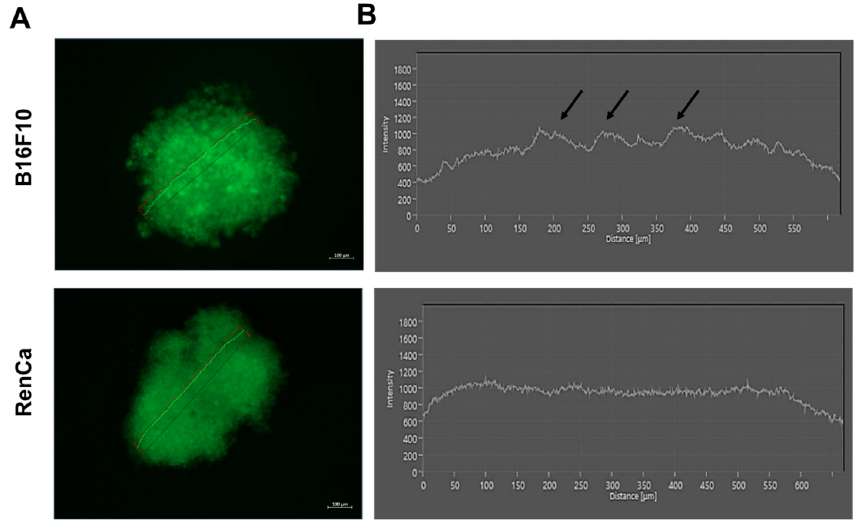
Figure 3. Drug distribution in the spheres. Immunofluorescent picture of doxorubicin (0.001 µ M) treated melanoma and renal cancer spheres after 48 h treatment—( A ). Histograms representing drug distribution in the cross-section of the sphere of melanoma and renal cancer model—( B